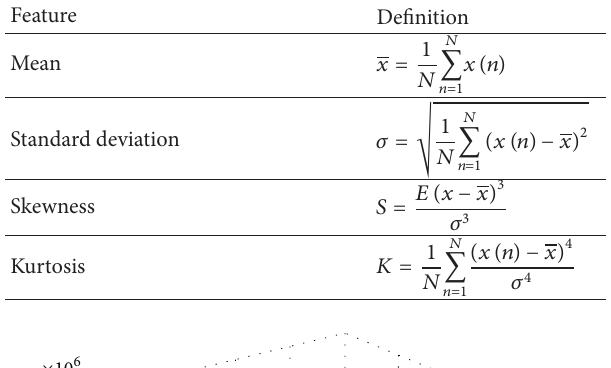
Table 1: Formula for the evaluation of statistical values.